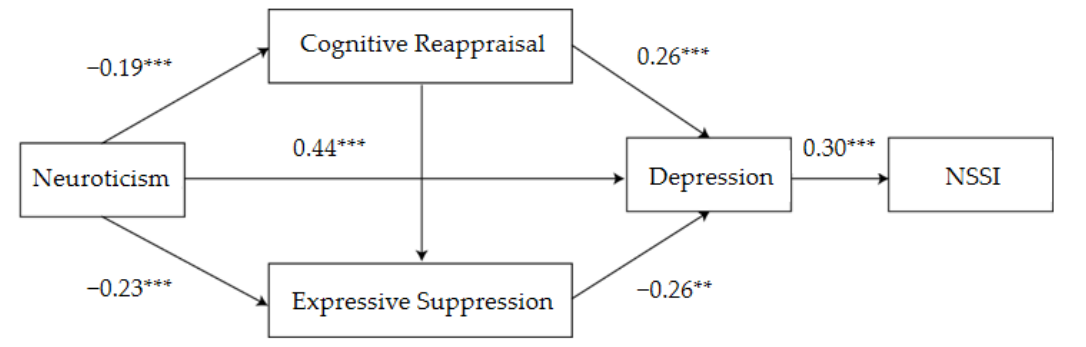
Figure 1. Influence of neuroticism on NSSI behavior: schematic diagram of the mediating role of emotion regulation and depression. ** p < 0.01, *** p < 0.001